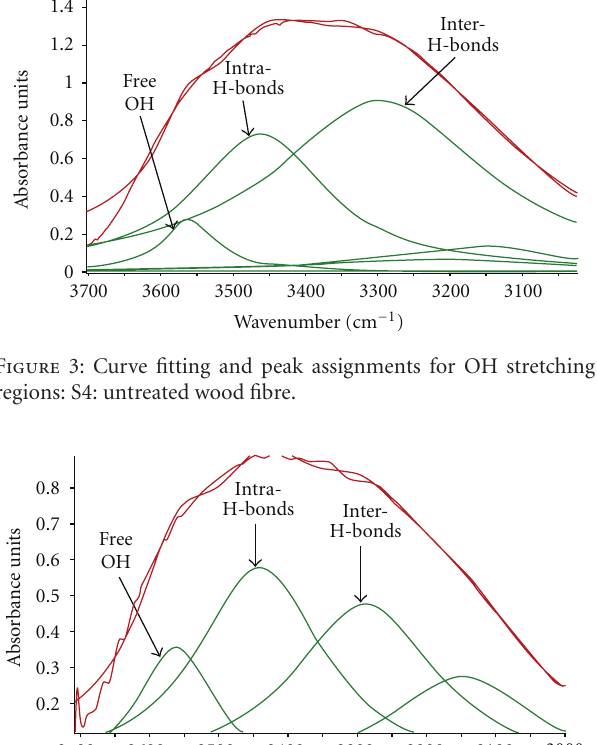
Table 1: Change in IR Index of wood fire with enzymatic treatment. ∗